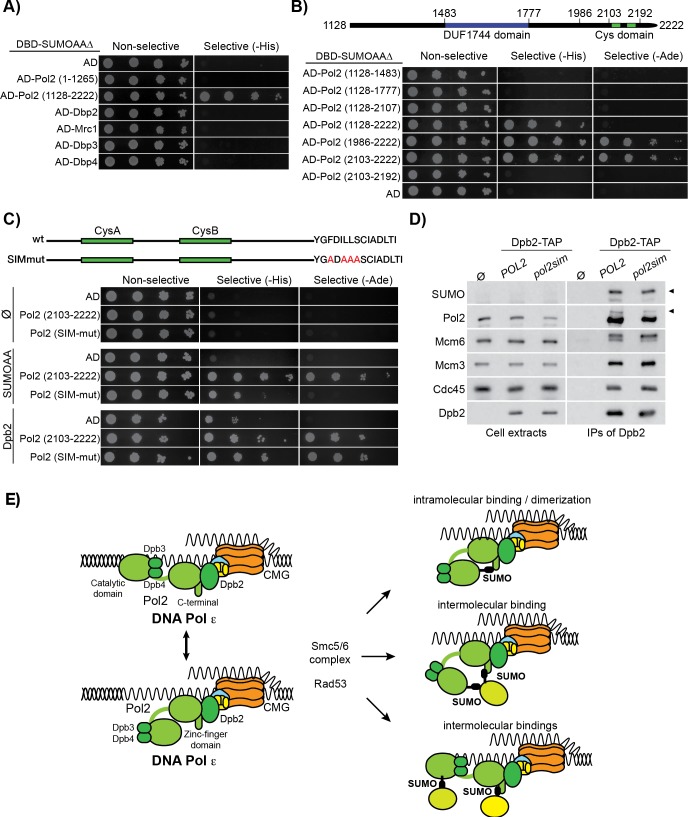
Pol2 C-terminal contains a SUMO-interacting motif (SIM).A) The C-terminal half of Pol2 interacts with SUMO. The ability of the subunits of Pol ε- Dpb2, Dpb3, Dpb4, Pol2 N-terminal (1–1265) and Pol2 (1128–2222)—and of Mrc1 to interact with SUMO (Smt3AAΔ, an allele that cannot be used as a moiety for SUMOylation) was tested by using the yeast two-hybrids assay. Pol2 C-terminal shows the ability to interact with SUMO. B) Mapping of the interaction between several fragments of Pol2 C-terminal half and SUMO was tested by yeast two-hybrids assay. Pol2 (2013–2222) fragment is sufficient for the interaction with SUMO, while the deletion of the last 30 amino acids blocks the binding. C) Identification of a SIM motif at the extreme C-terminal of Pol2. The analysis of the sequence identified a putative SIM sequence at the extreme C-terminal. Mutation of this sequence abolished the binding of the SUMO protein while not affecting the interaction with Dpb2. D) Pol ε composition and SUMOylation is not affected by the mutation of the SIM motif at the C-terminal. An untagged strain, POL2 or pol2sim cells carrying a TAP-tagged allele of DPB2, were grown to the exponential phase, arrested in G1 and synchronously released in YPD 0.2 M HU for 90 min. Dpb2-TAP was immunoprecipitated and protein samples were analysed by immunoblotting. E) Possible models of action of Pol2 SUMOylation in response to replication stress. Rad53, activated through the S phase checkpoint, and the E3 SUMO-ligase Mms21, interacting with the Pol ε, promote the SUMOylation of Pol2 at Lysine 571. This SUMOylation might then lead to (top) an intramolecular binding of SUMO by Pol2 SIM (or dimerization), (middle) recruitment of a SUMOylated factor at forks, or (bottom) recruitment of different proteins by the SUMO and SIM sequences.